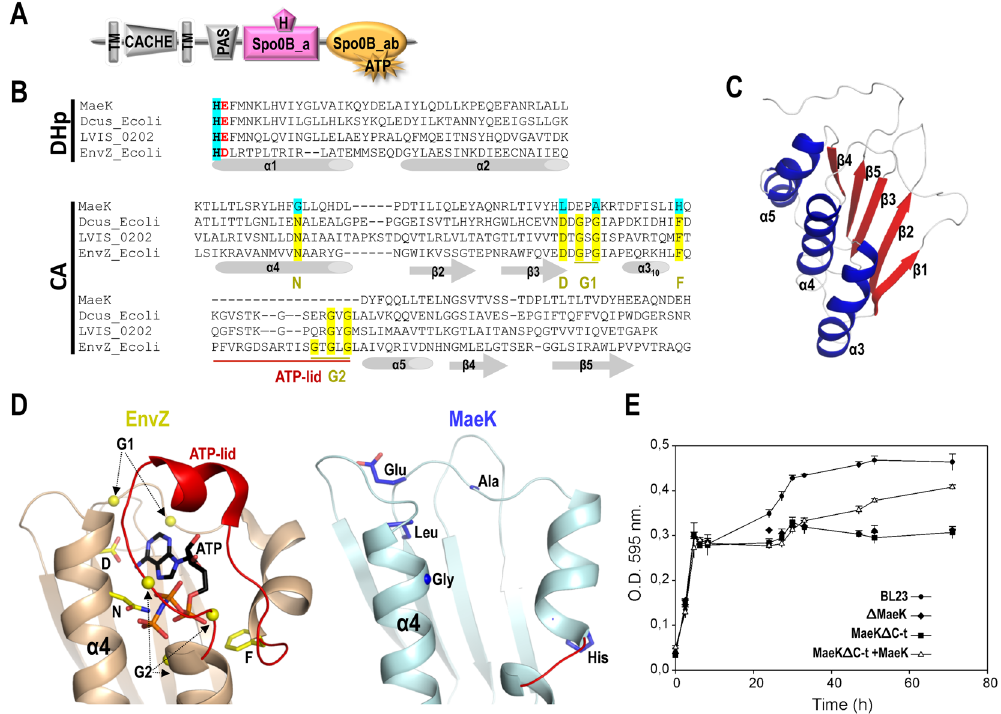
Figure 1. Domain composition and structural description of MaeK. ( A ) Graphical representation of the domains contained in MaeK, obtained with the SMART database and Pfam. TM correspond to transmembrane helix. ( B ) Sequence alignment of the Spo0B_a domain of MaeK with DHp domain of DcuS and EnvZ of E. coli containing the phosphorylatable His (in bold with blue pattern) and the subsequent catalytic acidic residue (colored in red). Below is represented the sequence alignment of the Spo0B_ab domain (degenerated CA domain) of MaeK with the CA domain of CitB from Lactobacillus brevis (LVIS_0202), and DcuS (DcuS_Ecoli) and EnvZ (EnvZ_Ecoli) from E. coli highlighting the conserved boxes for a canonical CA domain with their conserved specific residues in yellow pattern. Absence of conserved specific residues in MaeK contain blue pattern. ( C ) 3D structural model for the degenerated CA domain of MaeK generated by the program I-Tasser (helices in blue and beta strands in red). ( D ) Superposed 3D CA domain structures for EnvZ and MaeK to highlight the absence of conserved boxes and ATP-lid in MaeK with respect to EnvZ (colored as in B). ( E ) Growth of wild-type L. casei (BL23) and MaeK derivative strains. Wild-type (BL23), MaeK gene defective ( ∆ MaeK), MaeK lacking CA domain (MaeK Δ C-t) and MaeK Δ C-t complemented with a plasmid expressing MaeK (MaeK Δ C-t + MaeK) strains were grown in MEI medium supplemented with 5 g liter − 1 of L-malic acid. Values represent the means of three independent experiments; error bars represent standard